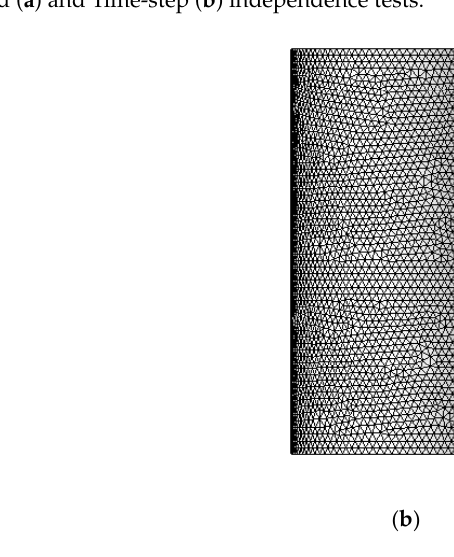
Figure 6. Example of the mesh grid used for the ( a ) coil tube and ( b ) shell.